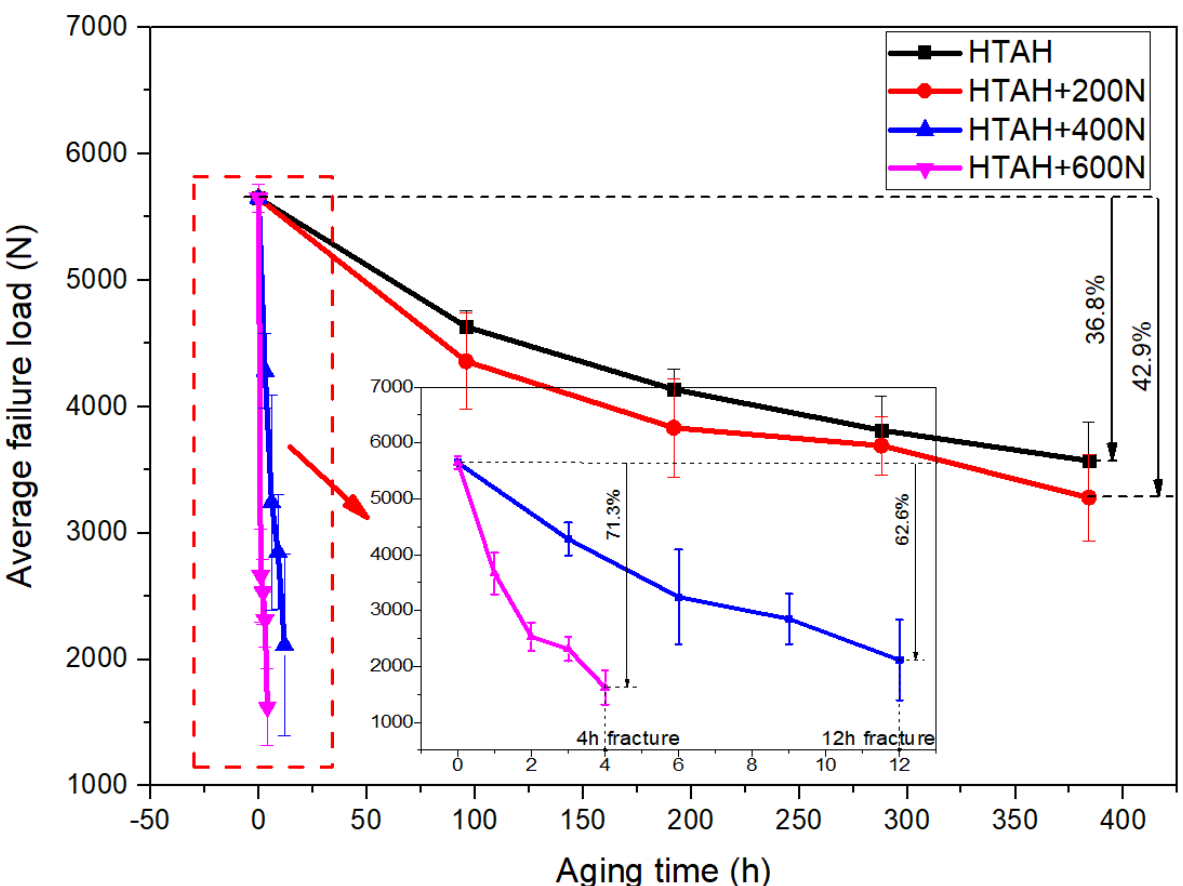
Figure 10. Variation curves of failure load under no-load and loading 200 N, 400 N and 600 N in HTAH conditions.